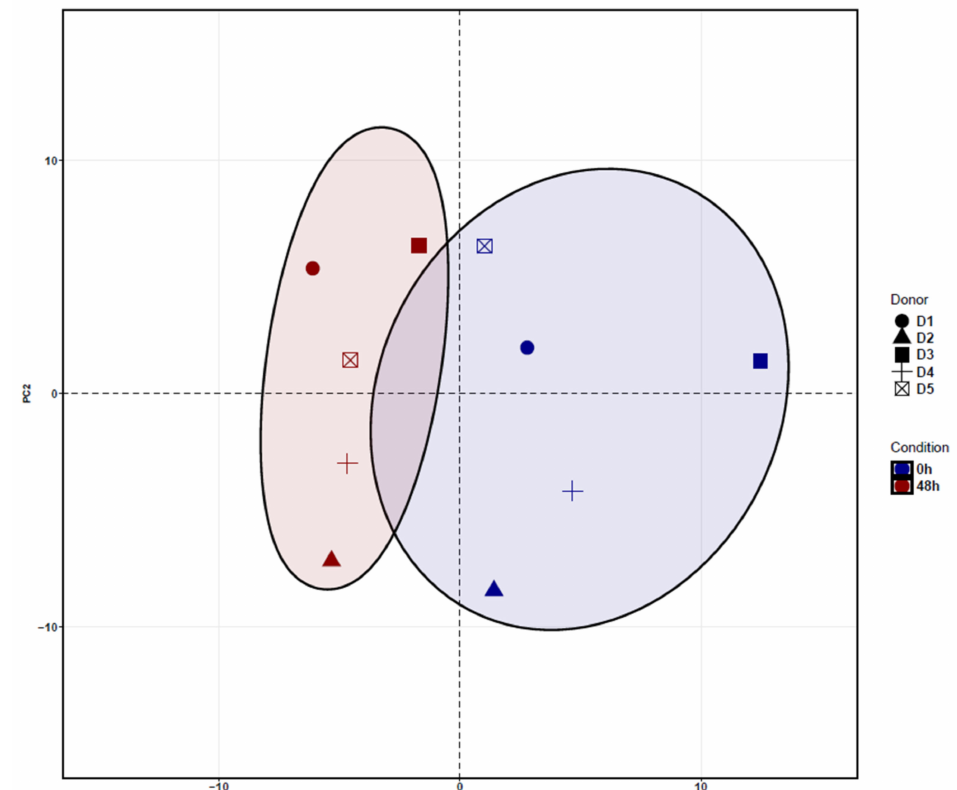
Figure 2. Principal Component Analysis (PCA) of cultured ADSCs for 48 h and uncultured ADSCs. The PCA revealed a clear clustering of cultured ADSCs (blue dots) and uncultured ADSCs (red dots) along the main component PC1. In addition, after cultivation of 48 h, ADSCs showed a separation along PC2, with a more homogeneous response, when compared to uncultured